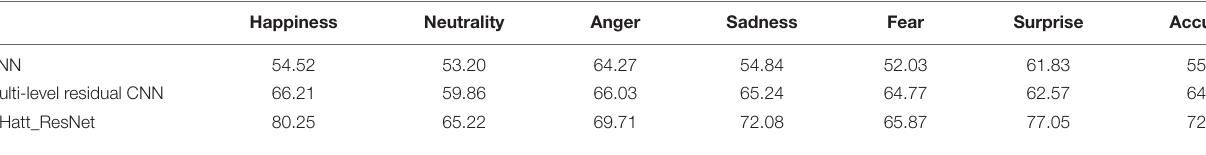
TABLE 2 | The accuracy of emotion classification by different methods (%).